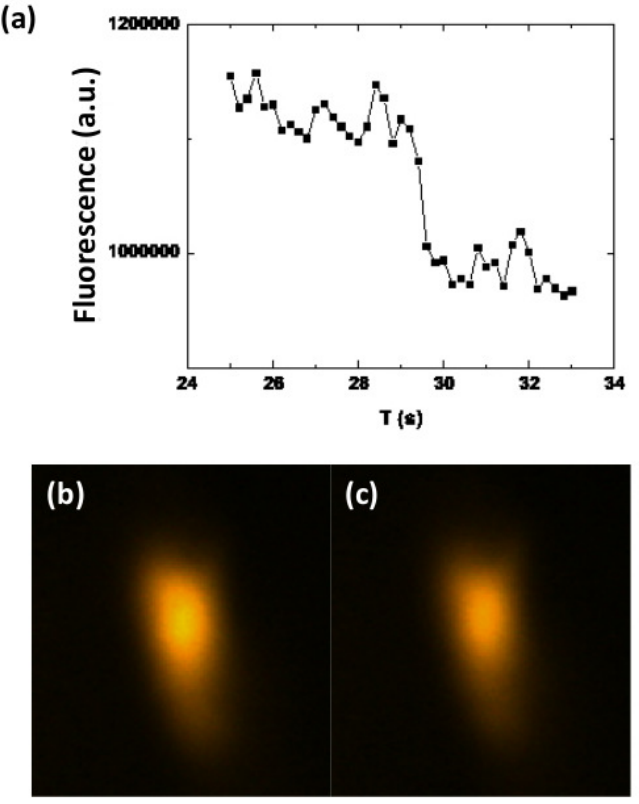
Figure 6. ( a ) the relative number of atoms as a function of time. The UV light was turned on at about 29 s, as shown in this plot. ( b ) The image was taken at about 28.4 s, as shown in ( a ). ( c ) The image was taken at about 32.4 s, as shown in ( a